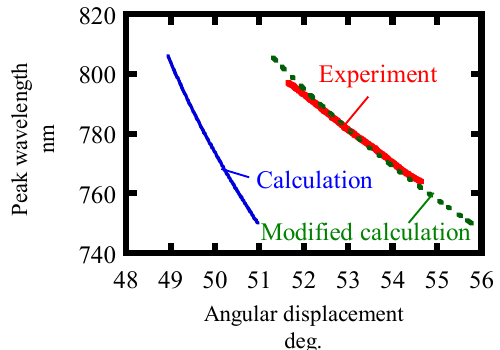
Figure 8. The sensitivity of the peak wavelength to the angular displacements.